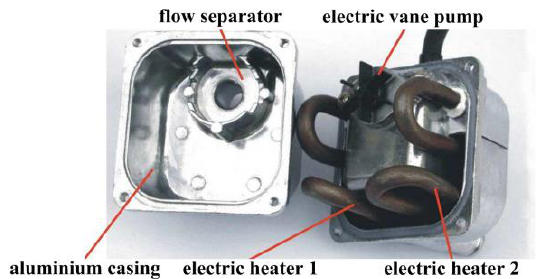
Fig. 4. Construction of LF Bros heater model D-12-8003 with 1000 W